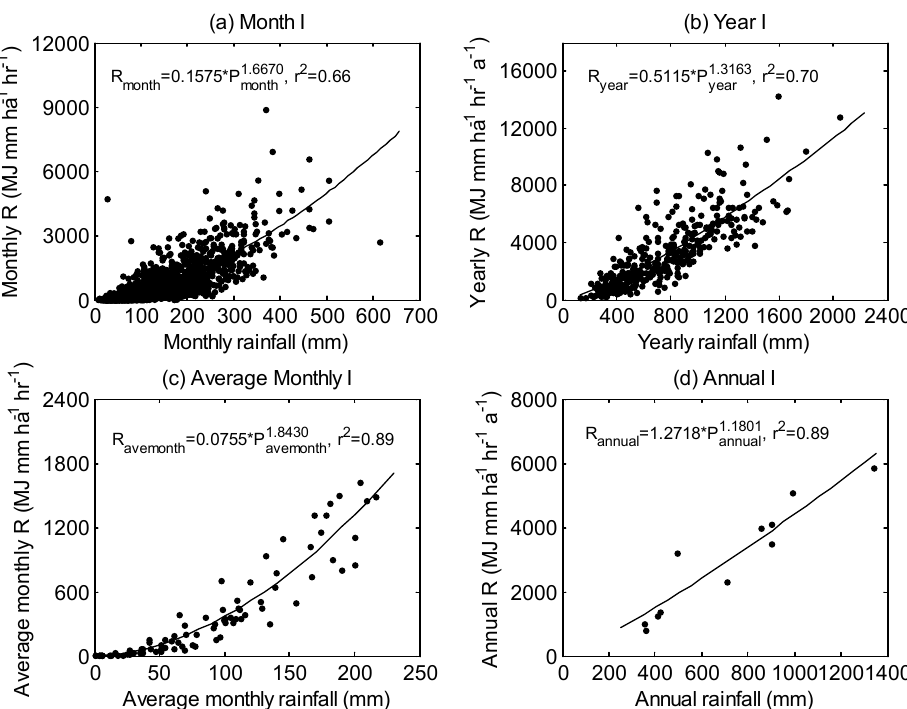
Figure 2. Scatterplots for power-law models using rainfall amount: (a) Month I, (b) Year I, (c) Average Monthly I, and (d) Annual I, based on the 11 calibration stations. Table 5. Validation station-averaged symmetric mean absolute percentage errors (MAPE sym ) and Nash–Sutcliffe model efficiency coeffi- cients (ME) for R month by Month I, R year by Year I and R ave_month by Average Monthly I models for seven validation stations and statistics on event rainfall amount and event EI 30